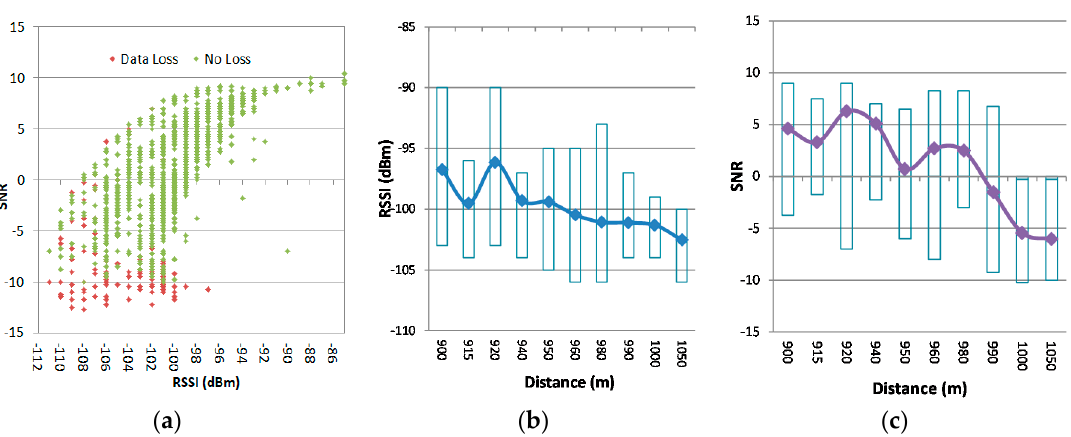
Figure 11. ( a ) Data loss at different RSSIs and SNRs, ( b ) RSSI and ( c ) RSSI changes with the distance between the SN and DS.